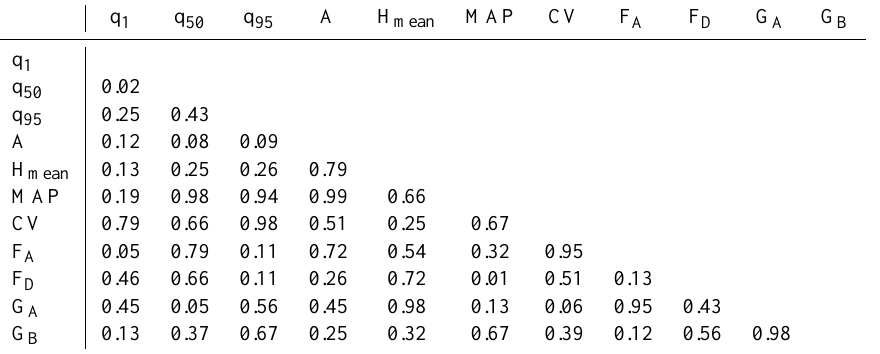
Table 4. p-value matrix to test the hypothesis of no correlation (critical value equal to 0.05%). q 1 q